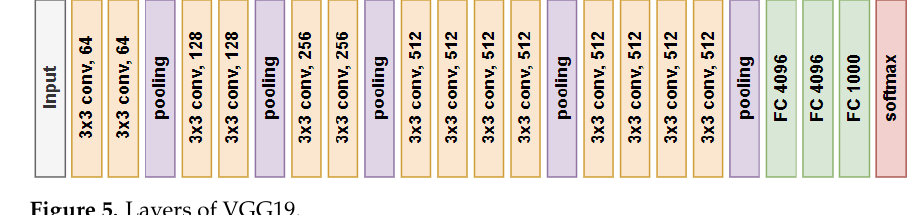
Figure 5. Layers of VGG19.